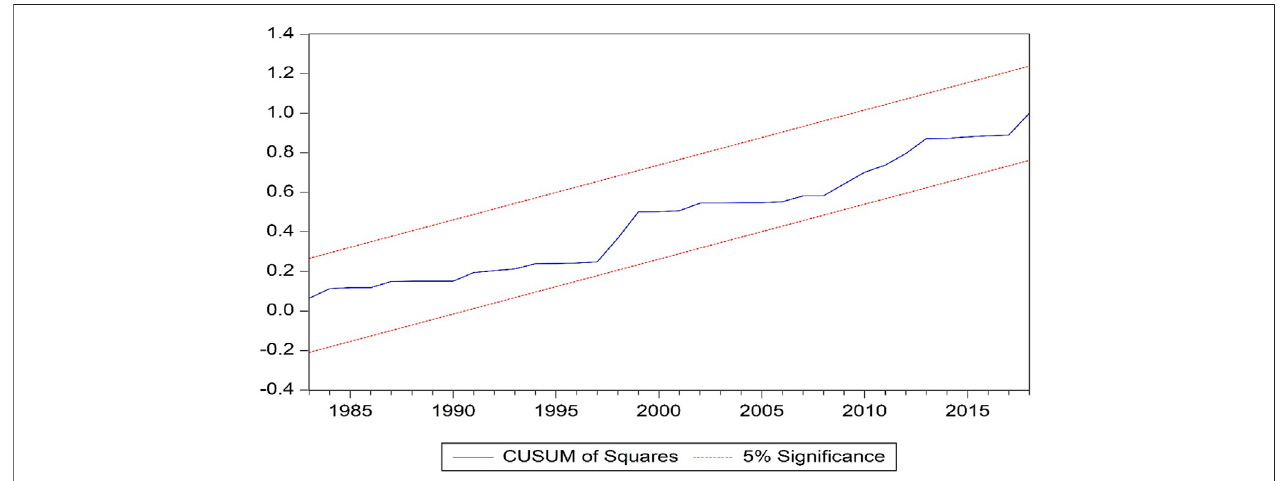
FIGURE 6 | CUSUMsq plot (model 1).